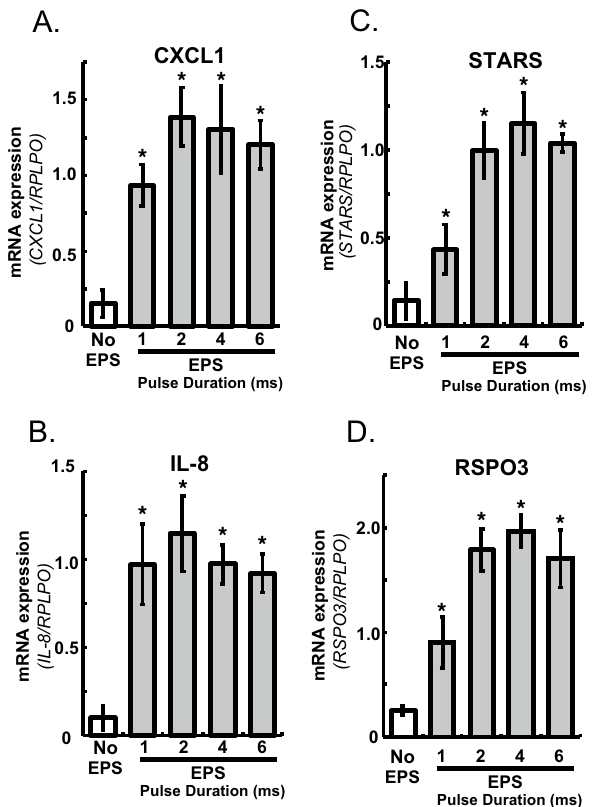
Figure 1. Human R-spondin 3 (RSPO3) mRNA expression evoked by EPS treatment. After 7–8 days of differentiation, the insert chambers were placed in an 8-well plate set on a C-Pace, and EPS (1 Hz, 20 V/25 mm) with a 1-, 2-, 4-, or 6-ms pulse duration was applied to the differentiated human myotubes for a total of 24 h, as described in the Methods. Total RNA samples were prepared and subjected to RT-PCR analysis to evaluate mRNA levels for CXCL1 (A), IL-8 (B), striated muscle activator of Rho signaling (STARS) (C), and RSPO3 (D). Data normalized using RPLP0 transcript were averaged over 3 independent experiments (* P <